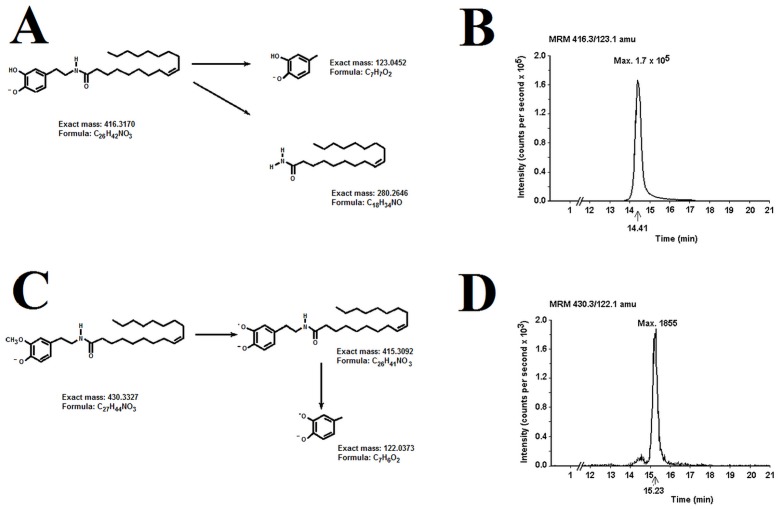

O-methylation of OLDA in vivo presented in the HPLC-MS spectra of brain extracts after intrarterial injection of OLDA.(A) Defragmentation of OLDA. (B) Chromatographic HPLC-MS peak typical for OLDA. The monitored ionic pair of OLDA of 416/123 (m/z) gave a retention time of 14.4. (C) Defragmentation of O-Me-OLDA. (D) Chromatographic HPLC-MS peak typical for O-Me-OLDA. The ionic pair of O-Me-OLDA of 430/122 (m/z) gave a retention time of 15.2. The signal at 430/122 indicates the presence of O-Me-OLDA in the sample (see text for details).